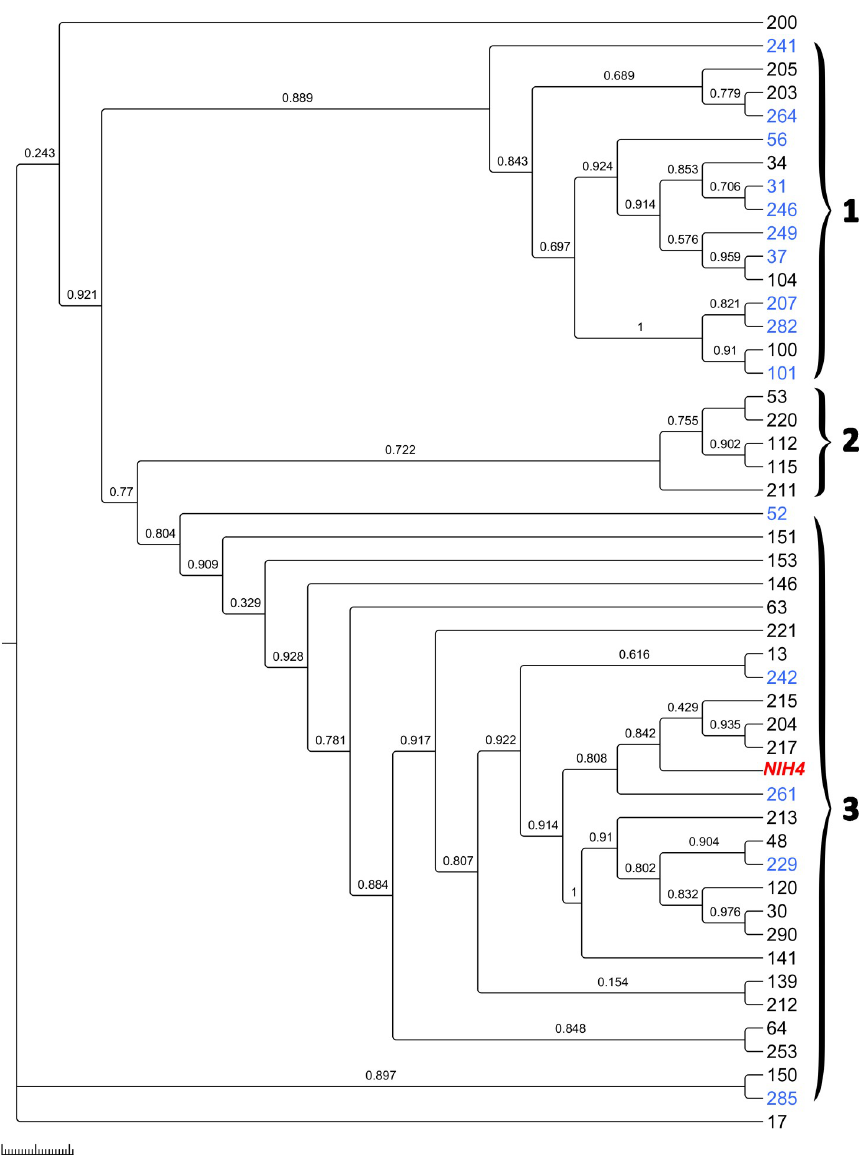
Fig 2. Trichomonas tenax relationship based on multilocus sequence typing phylogenetic analysis. Maximum likelihood phylogenetic tree of T . tenax strains. Colors legend: black for patients, blue for control and red for reference